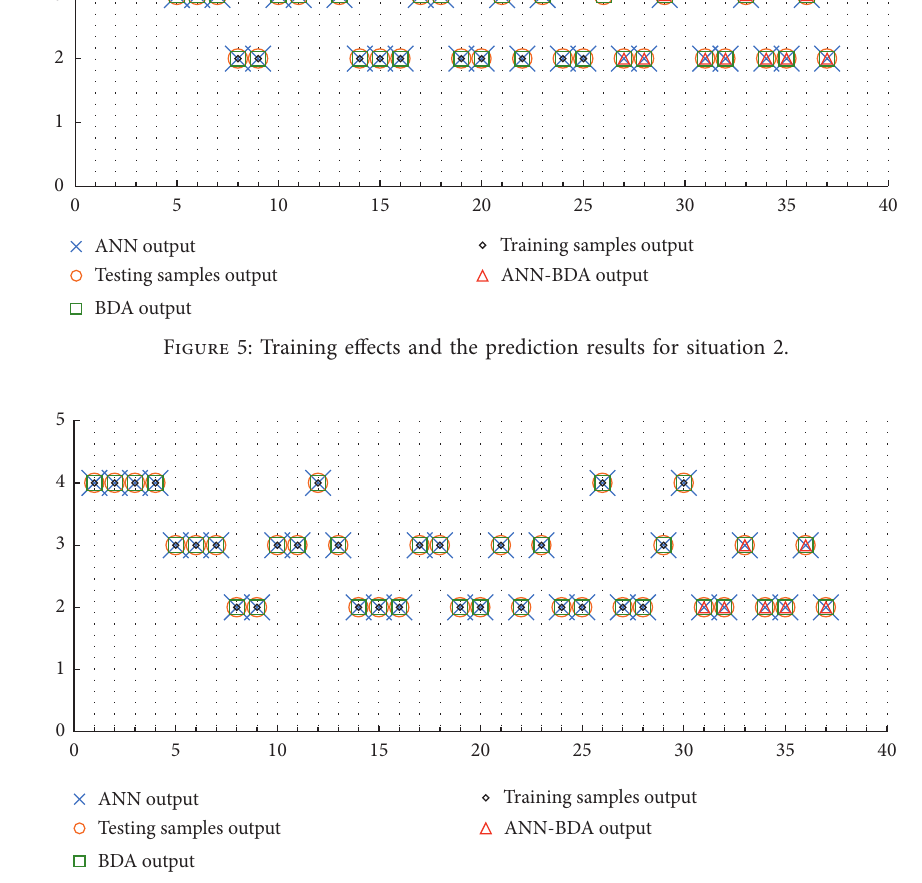
Figure 6: Training effects and the prediction results for situation